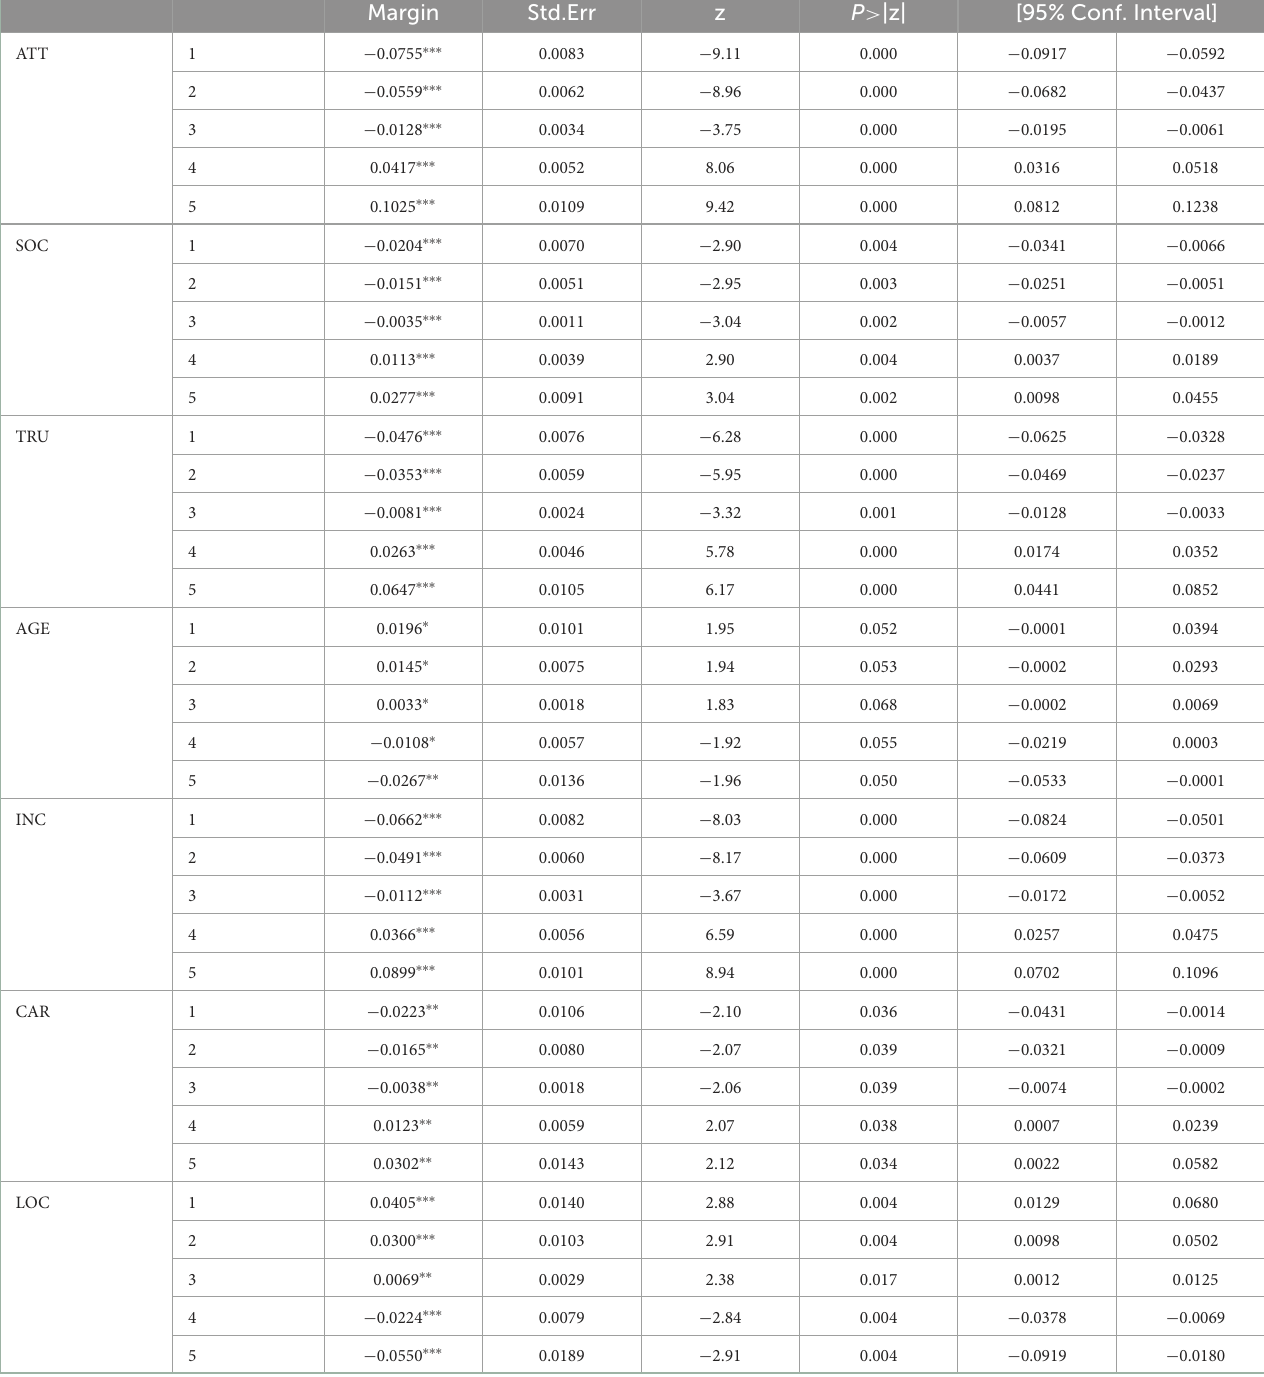
TABLE 4 Marginal effects of different factors before the